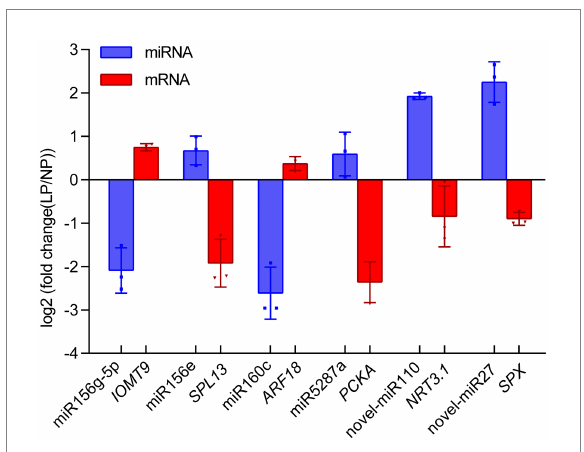
FIGURE 6 Quantitative real-time PCR validation of miRNA-mRNA interaction pairs in alfalfa roots responding to phosphate deficiency. Blue and red boxes represent the miRNAs and their target mRNA, respectively. Each column represents an average of three replicates, and error bars indicate the standard deviations. IOMT9 , isoflavone-7-O-methyltransferase 9 ; SPL13 , squamosa promoter-binding-like protein 13A ; ARF18 , auxin response factor 18 ; PCKA , Phosphoenolpyruvate carboxykinase (ATP ); NRT3.1 , high-affinity nitrate transporter 3.1 ; SPX , SPX domain-containing protein